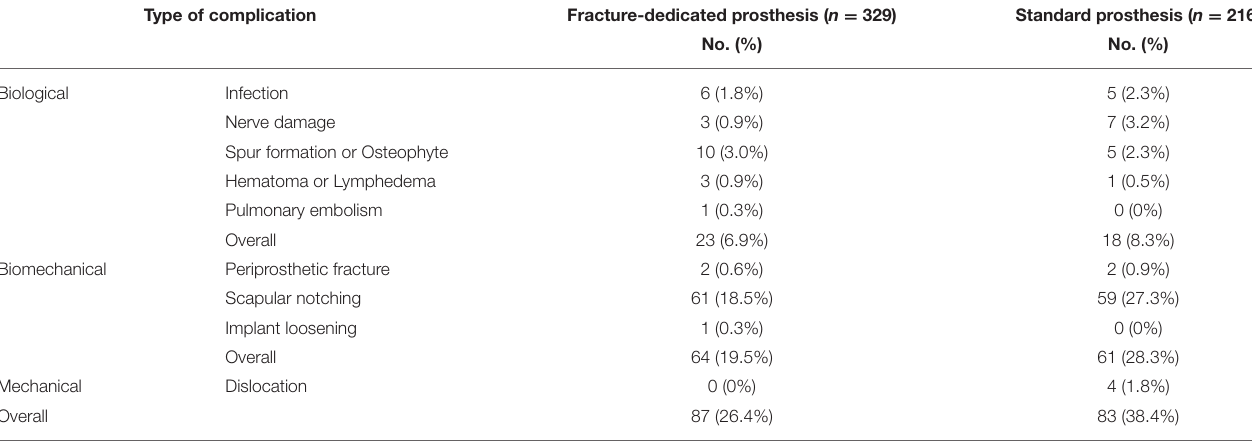
TABLE 5 | Differences of complication between the fracture-dedicated prosthesis and the standard